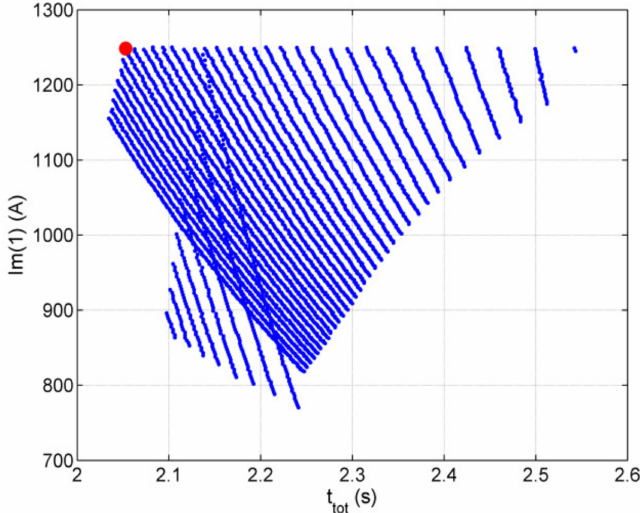
Figure 11. The relationship between the first peak value of the charging current and the total charging time for all feasible solutions of the Enumeration algorithm.